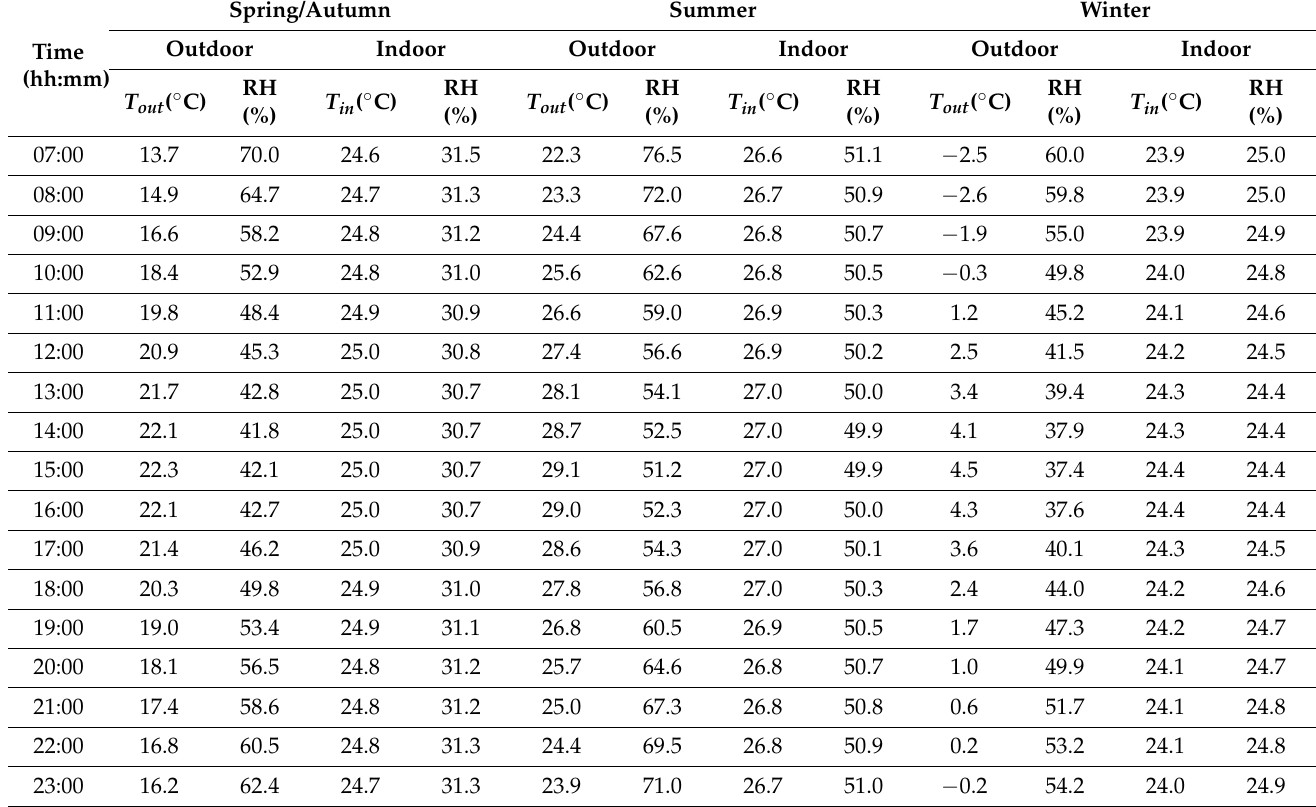
Table 2. Hourly indoor and outdoor temperature and humidity data by